Question: Write a single sentence explaining what this figure depicts.
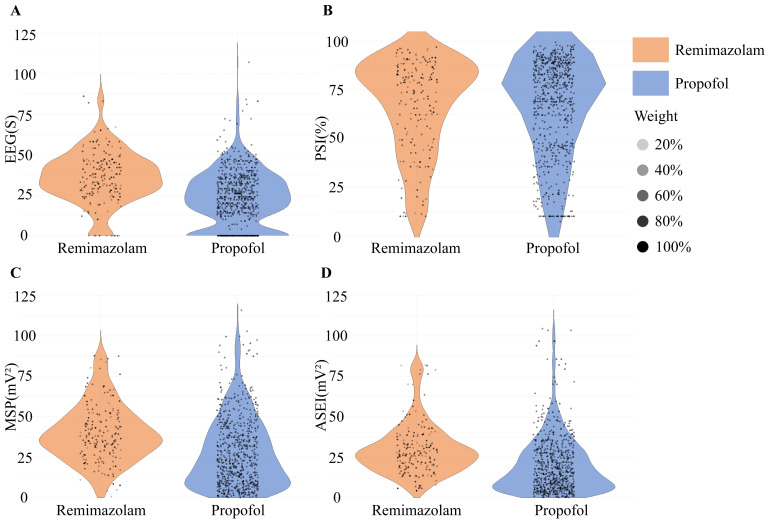
Answer: Comparison of ECT electroencephalographic monitoring parameters between the remimazolam and propofol groups. (A) Electroencephalographic sustained seizure duration; (B) Postictal suppression index; (C) Maximum sustained power; (D) Average seizure energy index. In the violin plots, each point represents one ECT session, with point shading reflecting sIPTW weight.